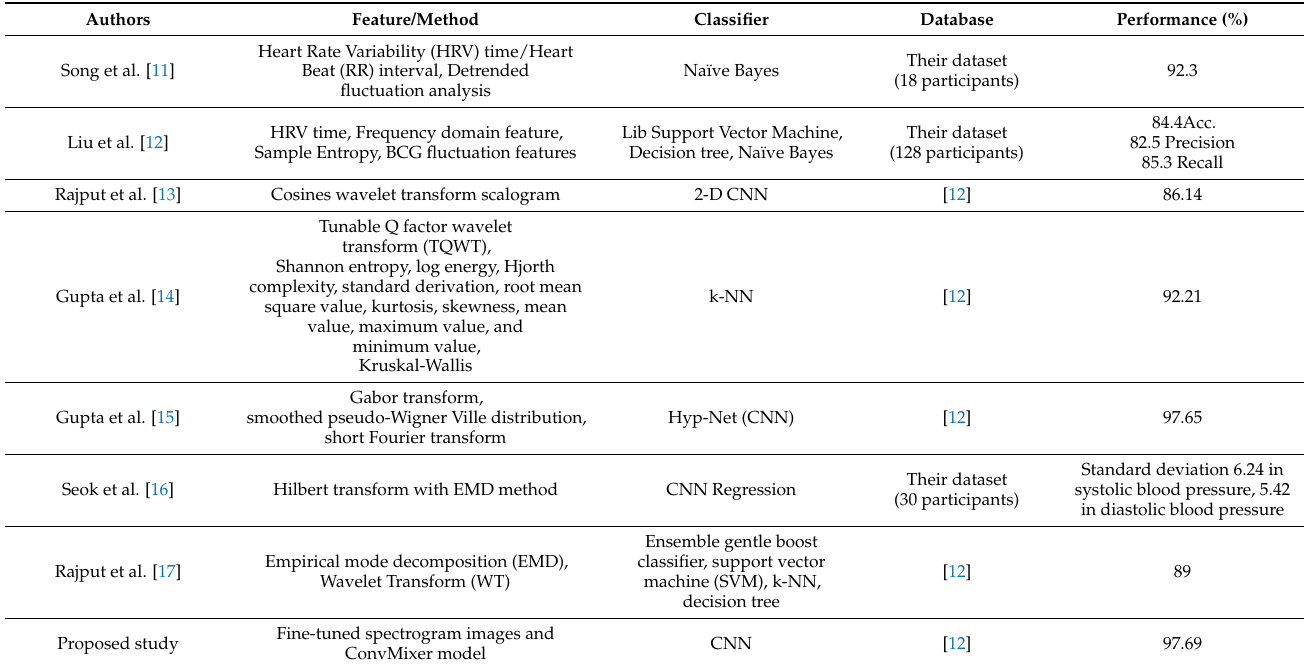
Table 4. Performance comparison of the proposed work with the state-of-the-art works carried out using similar BCG